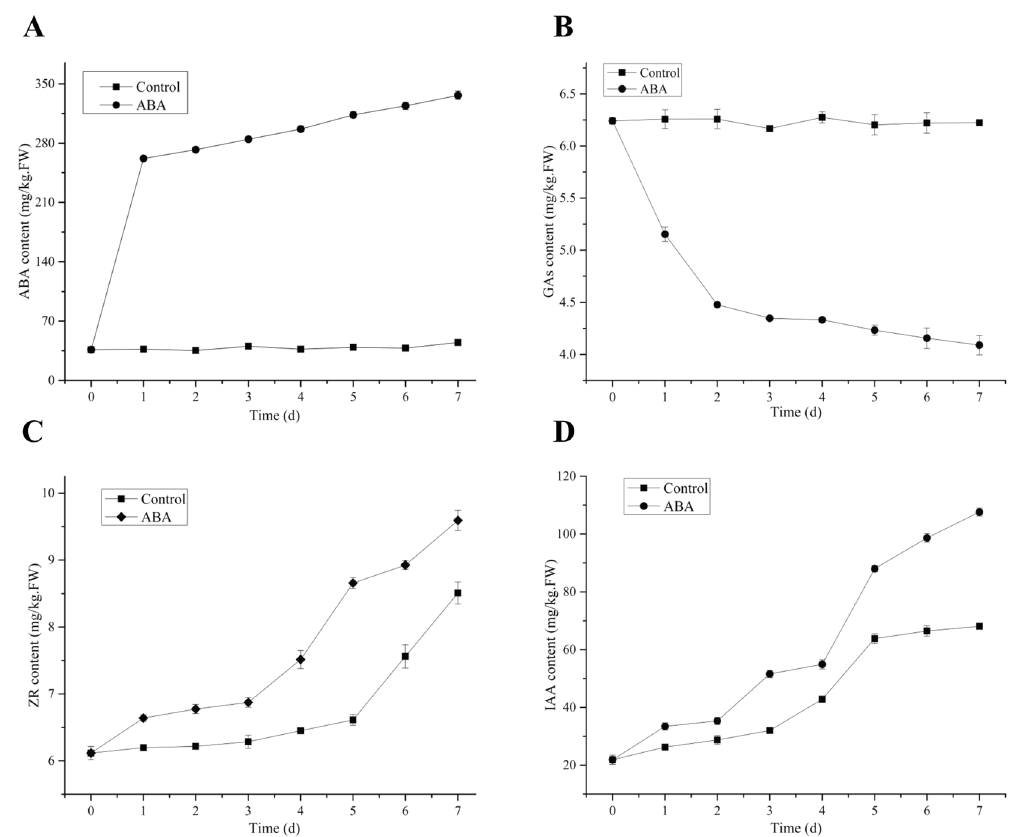
Figure 5. Effect of ABA treatment on endogenous ABA, GAs, ZR and IAA, levels in duckweed. ( A ) ABA content. ( B ) GAs content. ( C ) ZR content. ( D ) IAA content. FW, fresh weight. Values are given as the mean ± SD of three experiments for each